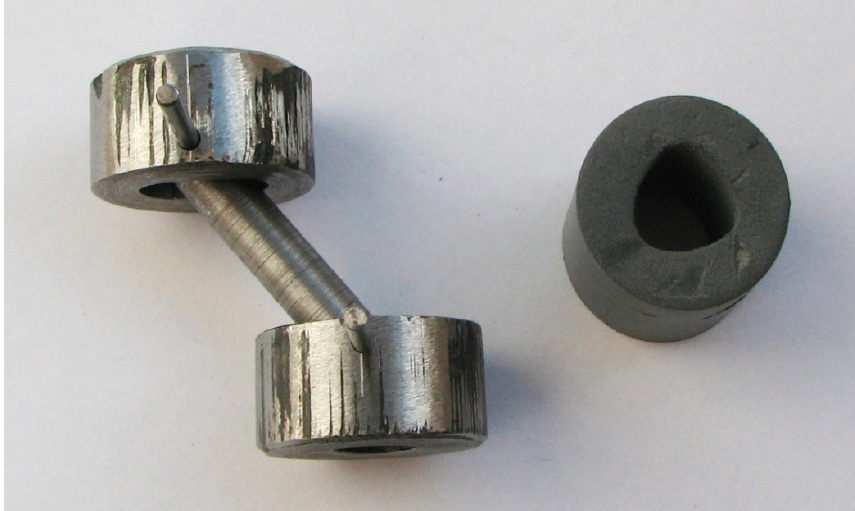
Figure 5. Components of the prototype PB: pin-ended steel core with the anchor plates ( left ), and a polymer cylinder with a centrally located hole ( right ).